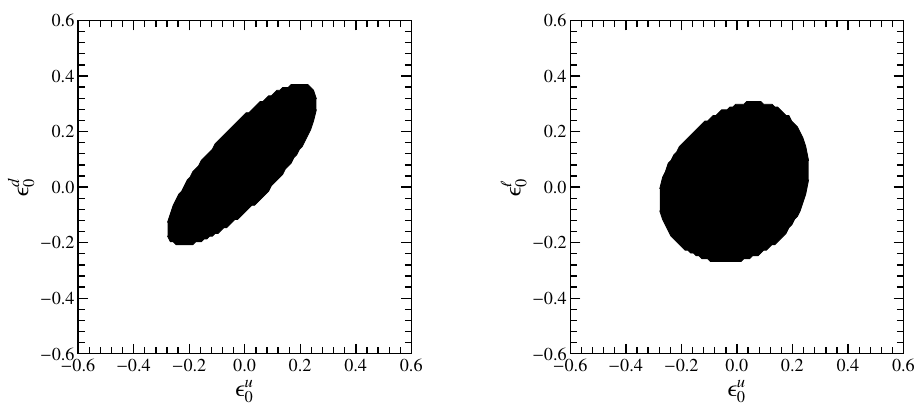
Figure 2 . Allowed region of ( (cid:15) u (left) and ( (cid:15) u